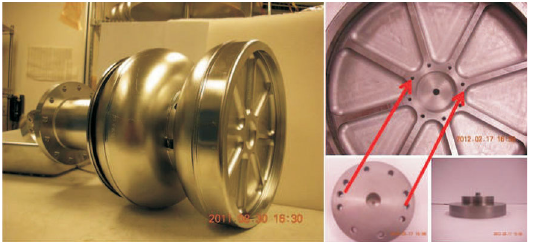
FIG. 1. Photograph of the cavity and the plug.